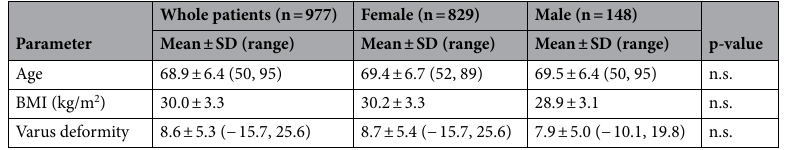
Table 4. Comparison of the age, BMI and varus-valgus deformity between Korean males and females. n.s. non-significant.